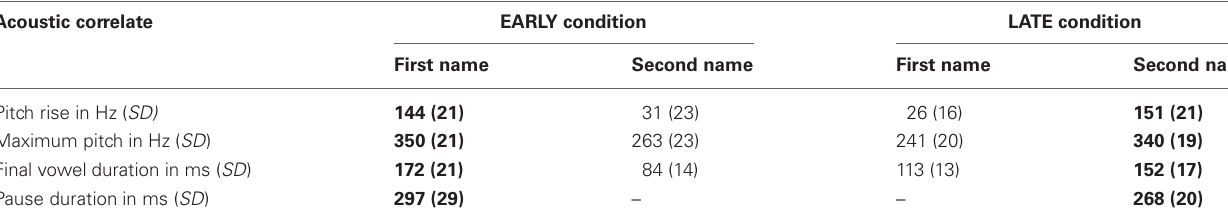
Table 1 | Mean acoustic correlates of prosodic cues in the experimental